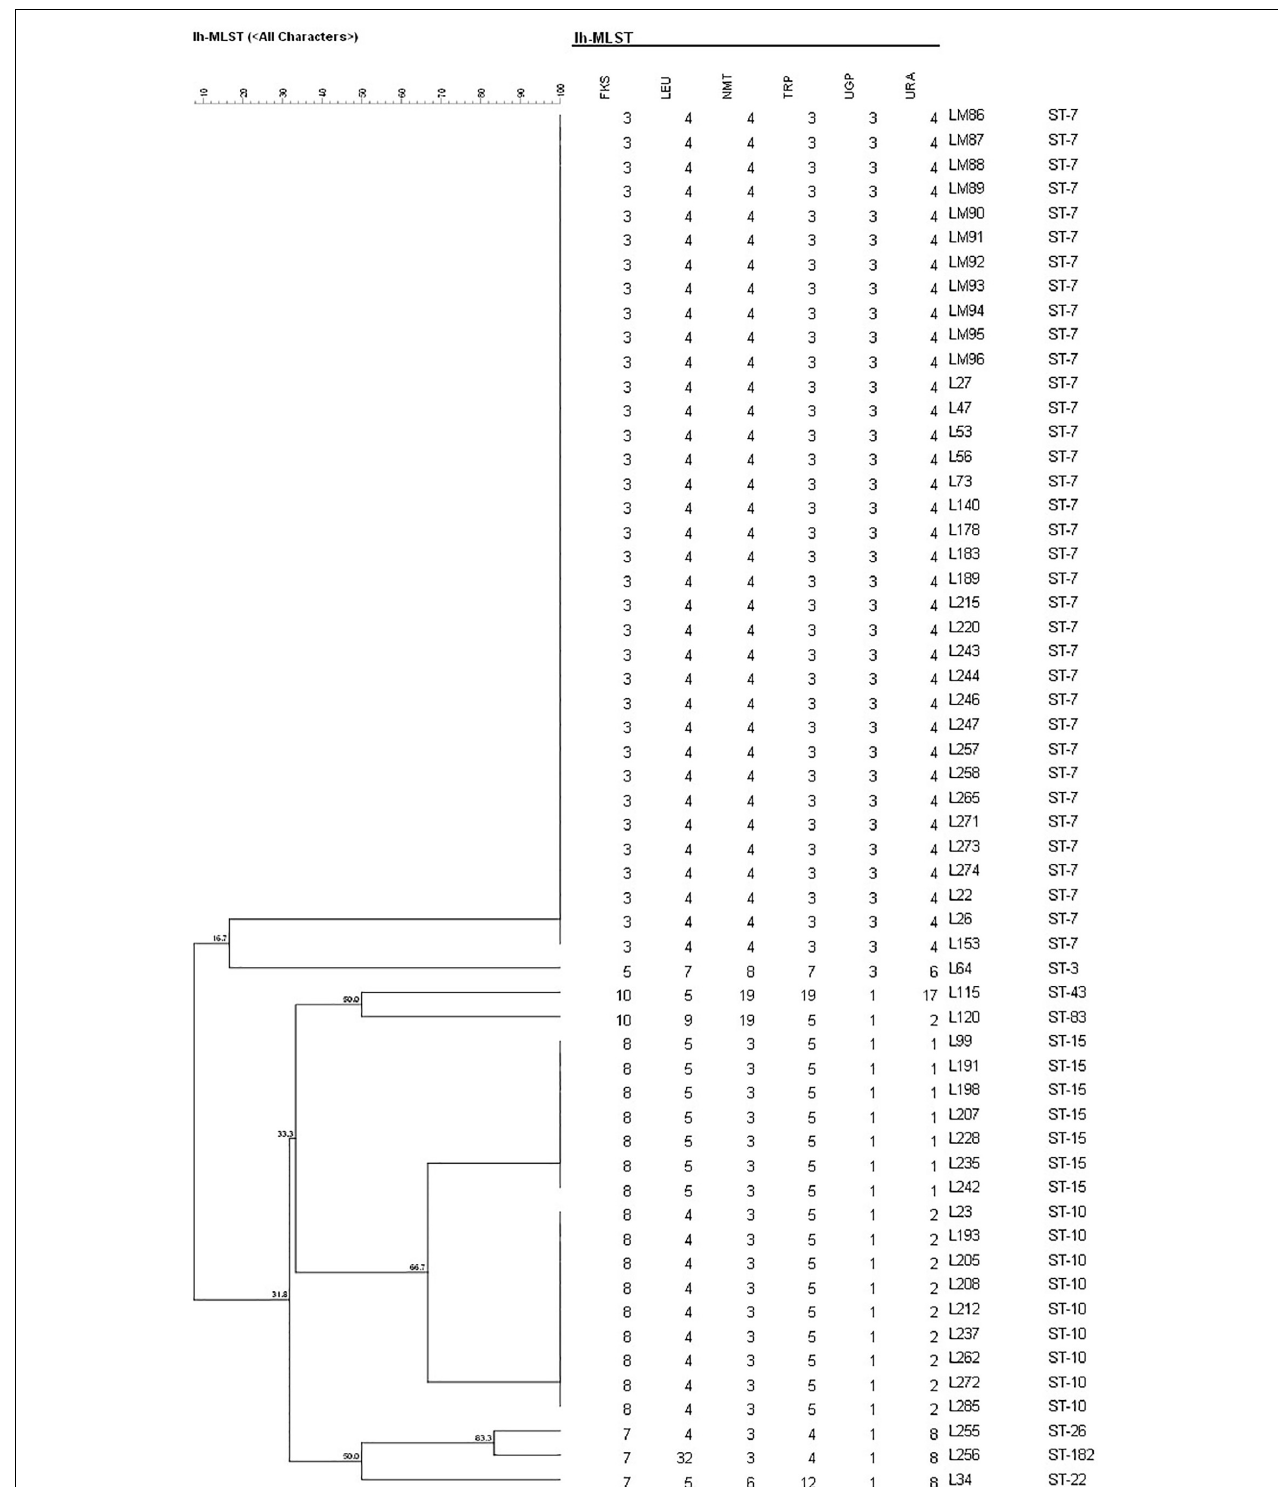
FIGURE 2 | Unweighted pair group method with arithmetic means dendrogram via BioNumerics software (version 7.6) showing the similarities among C. glabrata isolates. A similarity exceeding 80% was considered clonally related. The dendrogram demonstrates the genotyping of 57 non-vaginal C. glabrata isolates in Longhua Hospital, Shanghai University of Traditional Chinese Medicine. Sequence similarity was observed between ST26 and ST182 (83.3%).